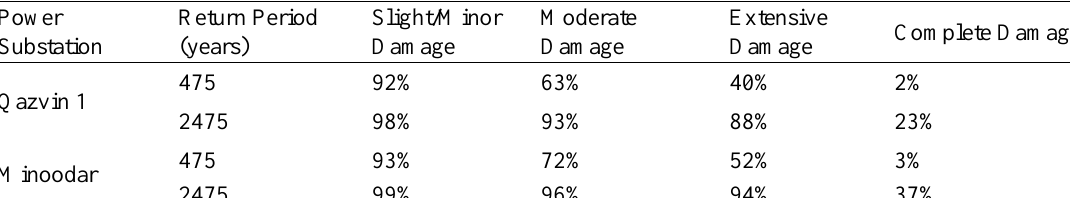
Table 10. Probability of exceeding from each damage state for Qazvin 1 and Minoodar power substations using HAZUS method for earthquakes with different return periods